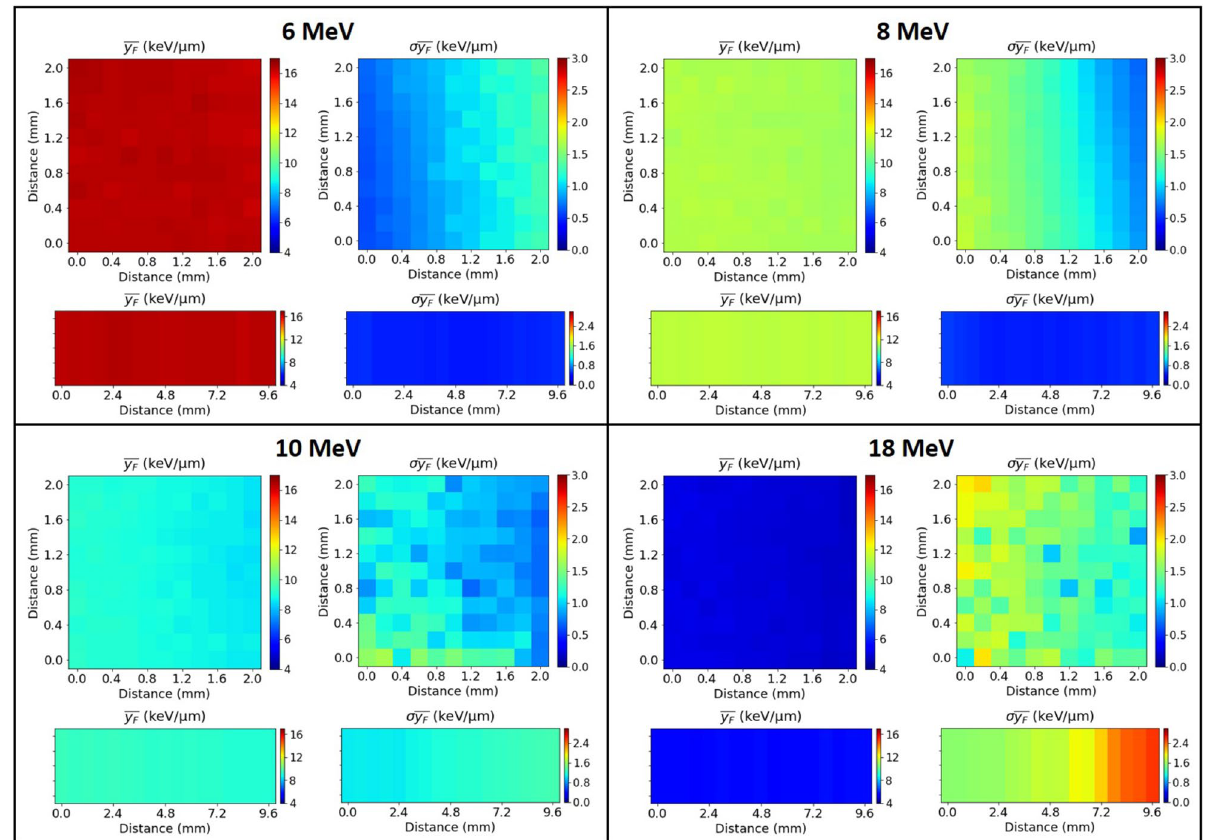
y F and σ y F obtained with four representative energies. In each quadrant are depicted the Figure 9. Results of ¯ ¯ results for the full pixel-type system (top) and for 1 cm representative region of the pad-type system (bottom).